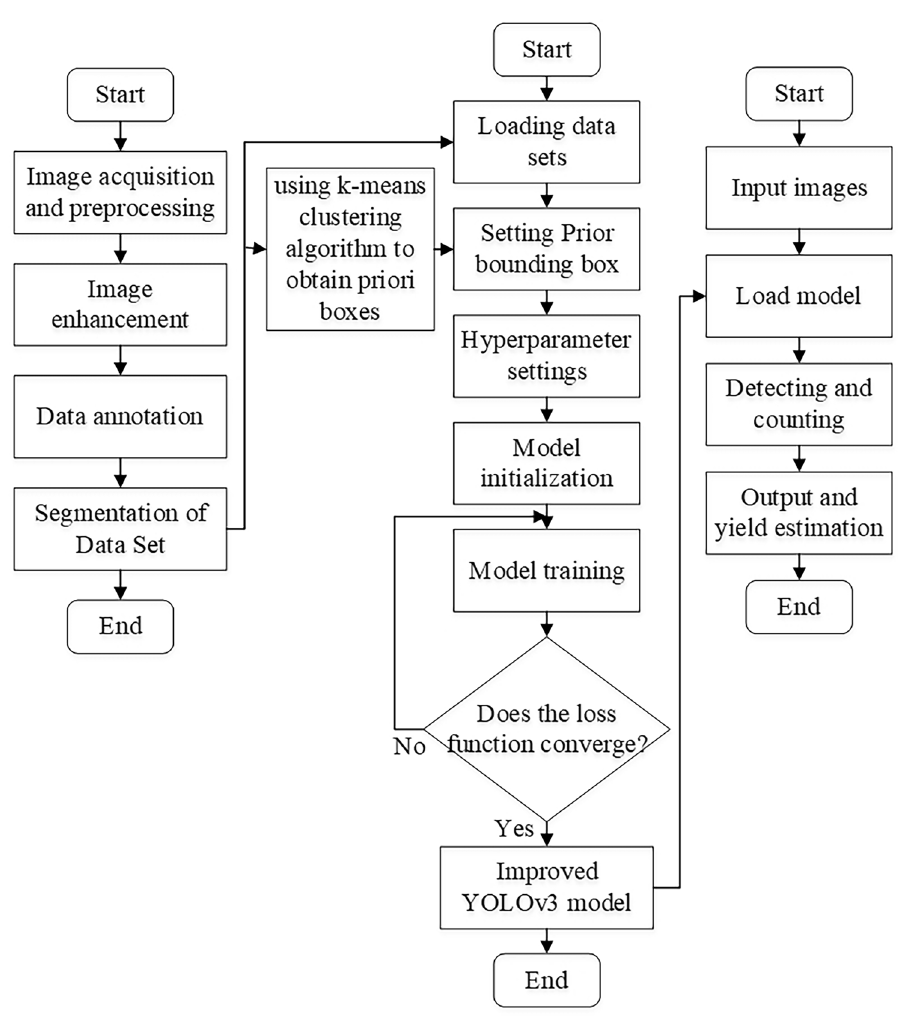
Figure 8. Algorithm flow